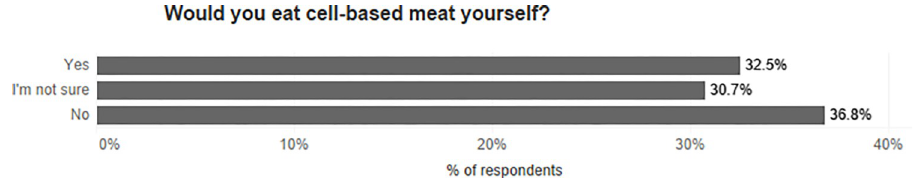
Fig 1. Willingness to try cultivated meat.